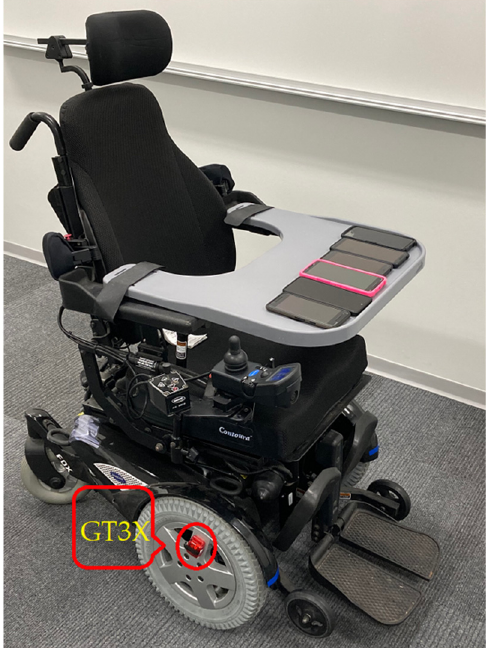
Figure 7. System settings for experimental series 2.